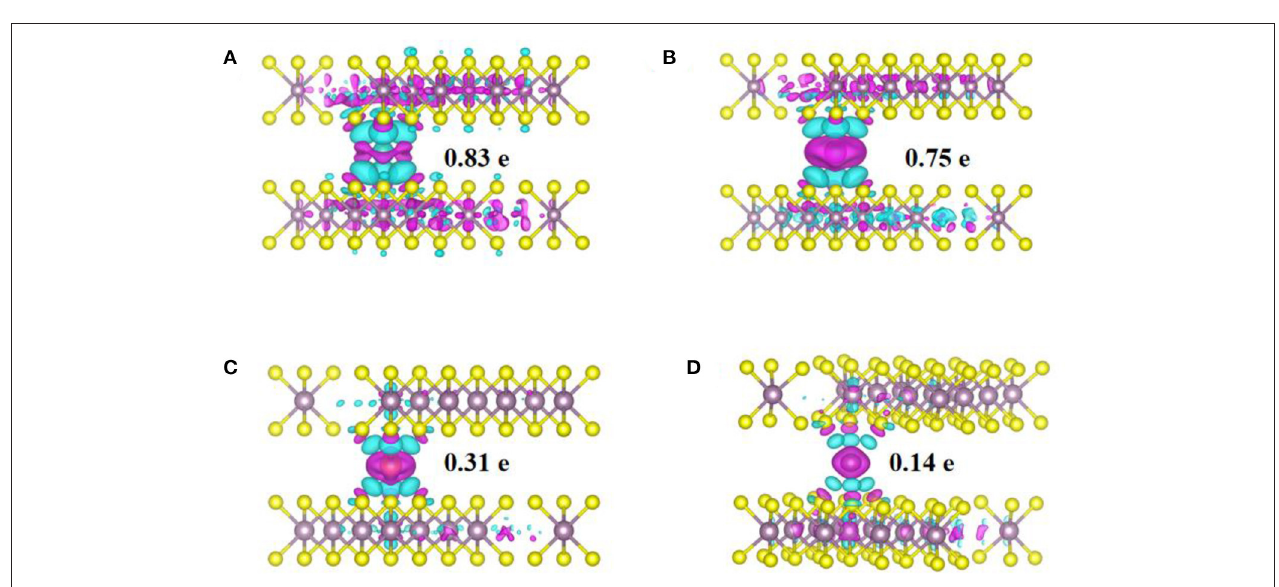
FIGURE 3 | The charge density difference and bader charge transfer of M-ions in MoS 2 structure. (A) Li-ion, (B) Na-ion, (C) Mg-ion, (D)